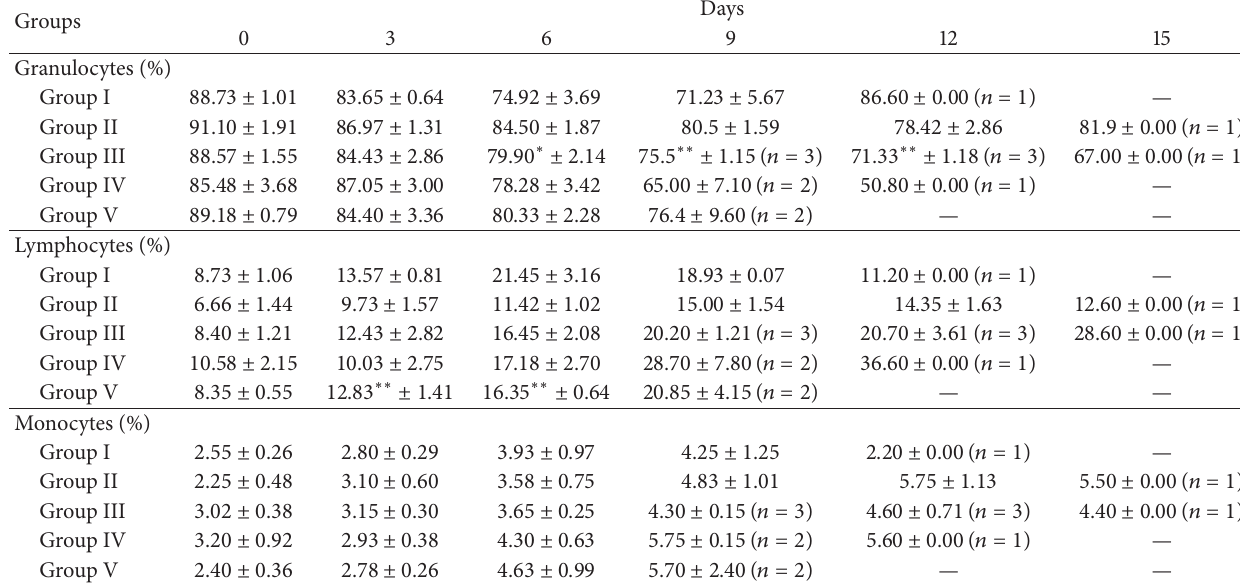
Table 7: Differential leukocyte count (%) in dogs of different groups at various observation intervals (mean ± S.E.). Groups